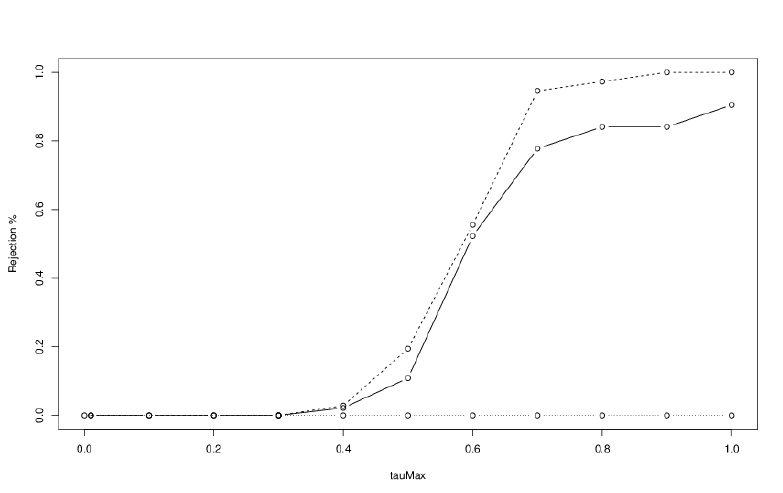
Figure 2: Rejection percentages for the statistics I 2, n (15) as a function of τ max : we use the gaussian copula, with a conditional parameter θ ( x ) calibrated such that the conditional Kendall’s tau τ ( x ) satisfies τ ( x ) = τ max · Φ ( x ) . Solid line: bootNP. Dashed line : bootPseudoInd. Dotted line : bootCond.